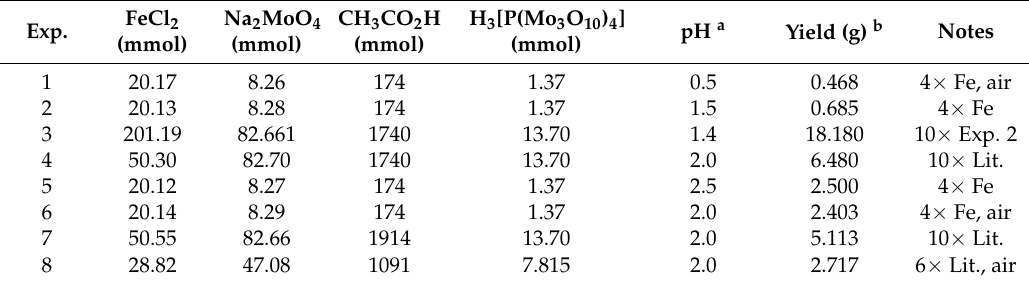
Table 1. Summary of [H x PMo 12 O 40 ⊂ H 4 Mo 72 Fe 30 (O 2 CMe) 15 O 254 (H 2 O) 98-y (EtOH) y ] (FeMoC) synthesis